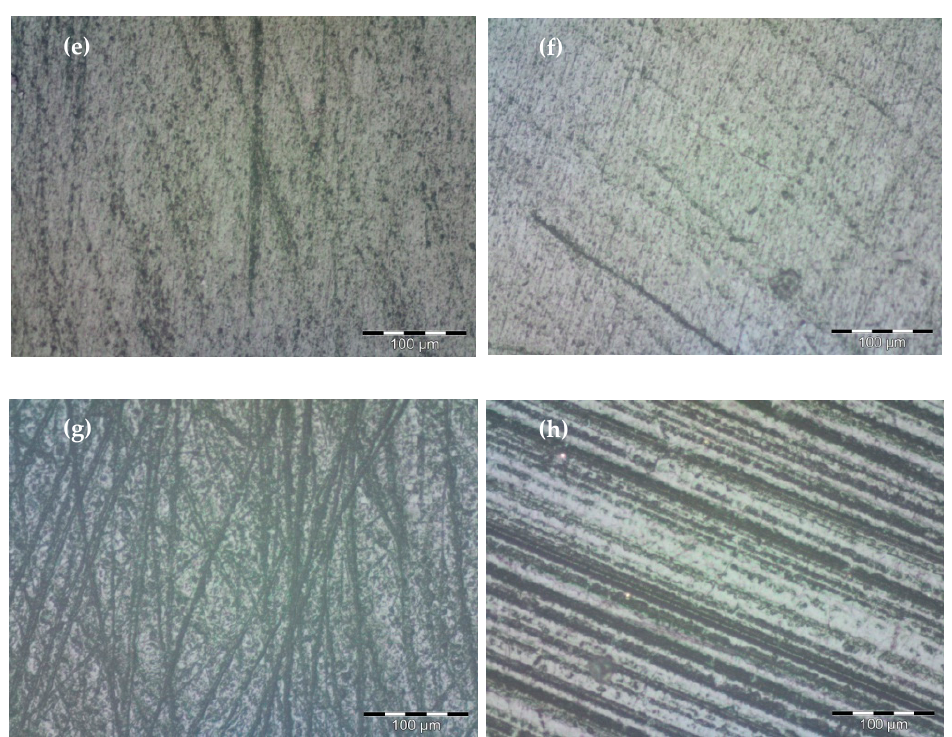
Figure 4. Photos from an optical microscope at 100 times magnification: ( a ) FU after polishing with Super Snap; ( b ) FZ after polishing with Super Snap; ( c ) FU after polishing with Enamel Shiny; ( d ) FZ after polishing with Sof-lex; ( e ) FZ after polishing with Sof-lex Diamond Polishing System; ( f ) FZ after polishing with Jiffy Polishing System; ( g ) FU after polishing with One Gloss; ( h ) FZ after polishing with